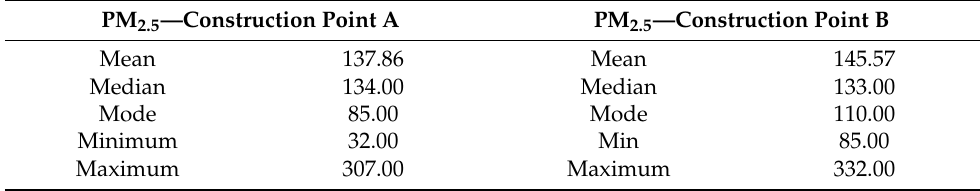
Table 1. Descriptive statistics for PM 2.5 concentration at the construction site (in μ g/m 3 ).